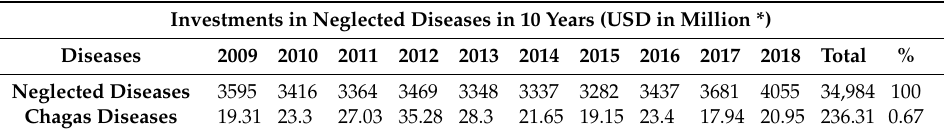
Table 1. Investments in neglected diseases over 10 years